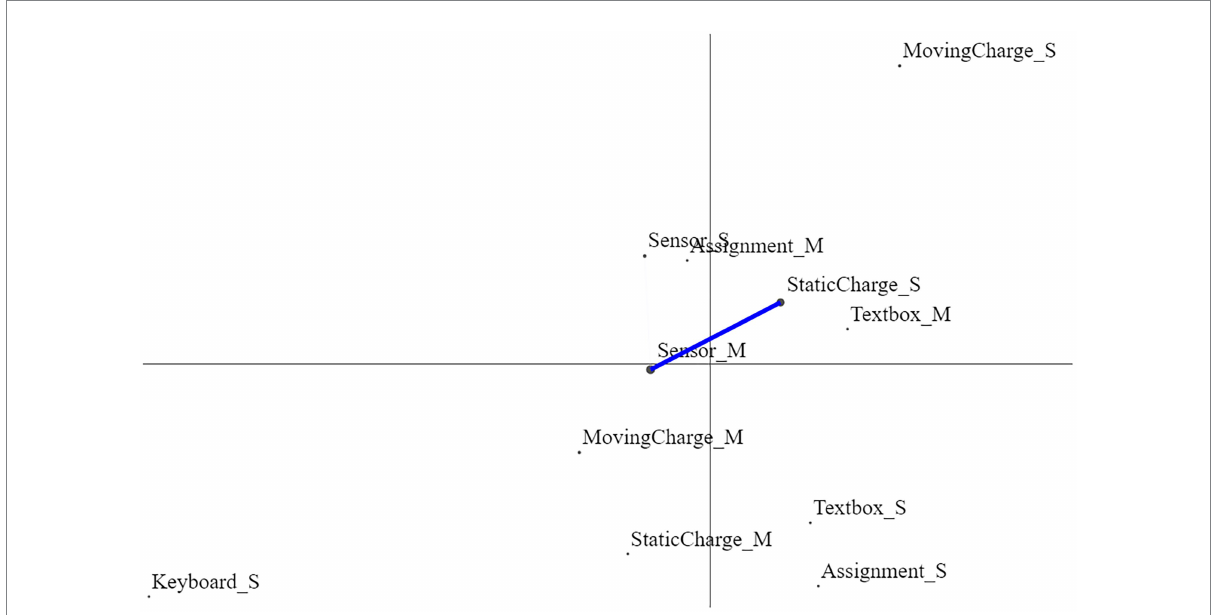
FIGURE 10 Epistemic networks of the gaze behavior of pair 2 during the evaluation (pair 1 did not evaluate their collaborative knowledge construction process). S and M after the underscore refer to the gaze of the sharing student (2S) and monitoring student